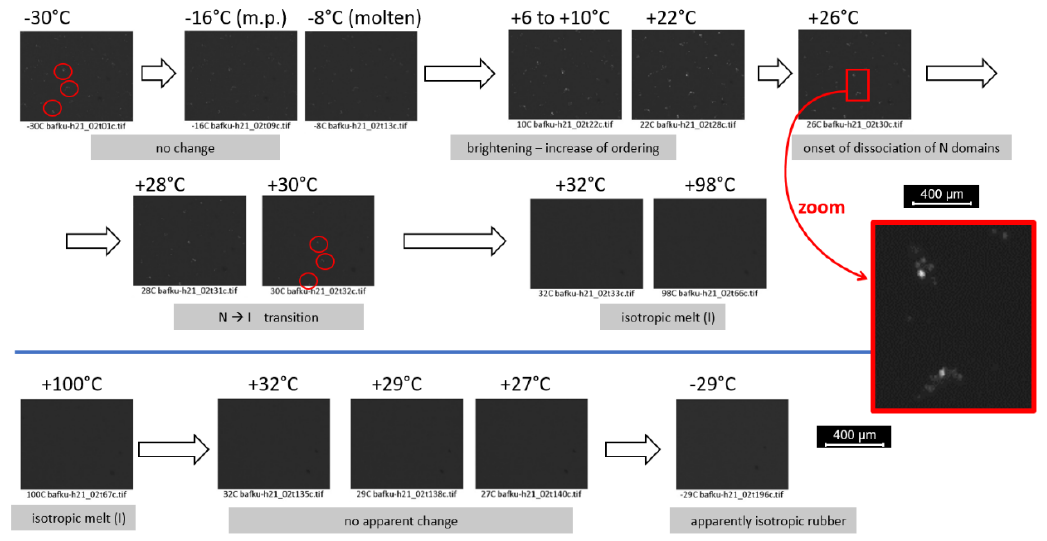
Figure 8. Textures observed in BAFKU–H21, top: heating run; bottom : cooling run; large representative images of each characteristic texture are shown in the Supplementary Materials, SI Figures S28–S30.